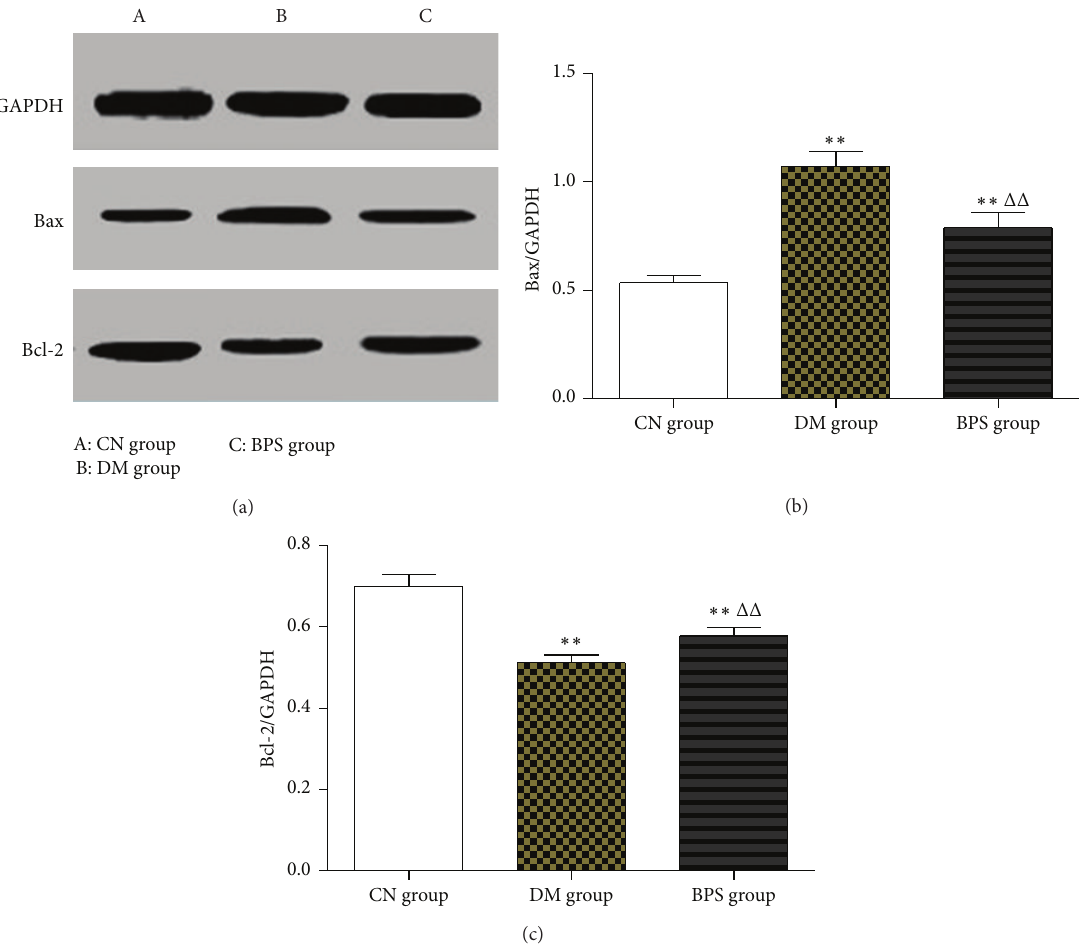
Figure12:Proteinlevelofapoptosisgenesinthemyocardia.ComparedwiththeCNgroup,theexpressionoftheBaxproteininthemyocardial tissues of rats in the DM and BPS groups significantly increased ( 𝑃 < 0.01 ). Compared with the DM group, the expression of the Bax protein in the BPS group significantly decreased ( 𝑃 < 0.01 ). Compared with the CN group, the expression of the Bcl-2 protein in the myocardial tissues of rats in the DM and BPS groups significantly decreased ( 𝑃 < 0.01 ). Compared with the DM group, the expression of the Bcl-2 protein in the BPS group significantly increased ( 𝑃 < 0.01